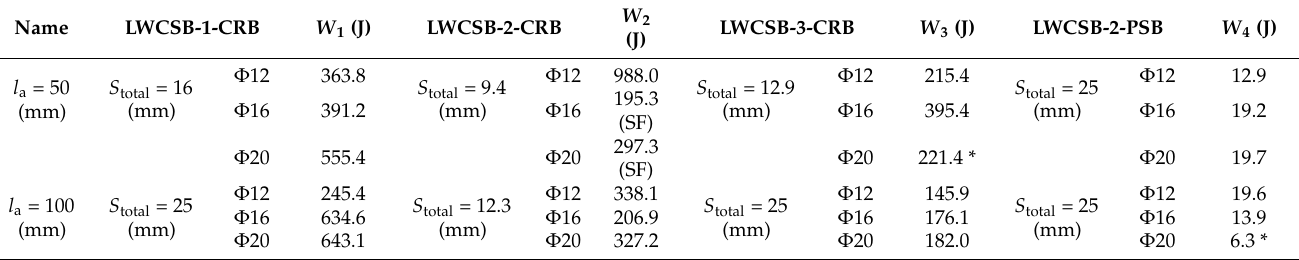
Table 5. The total energy consumption with representative